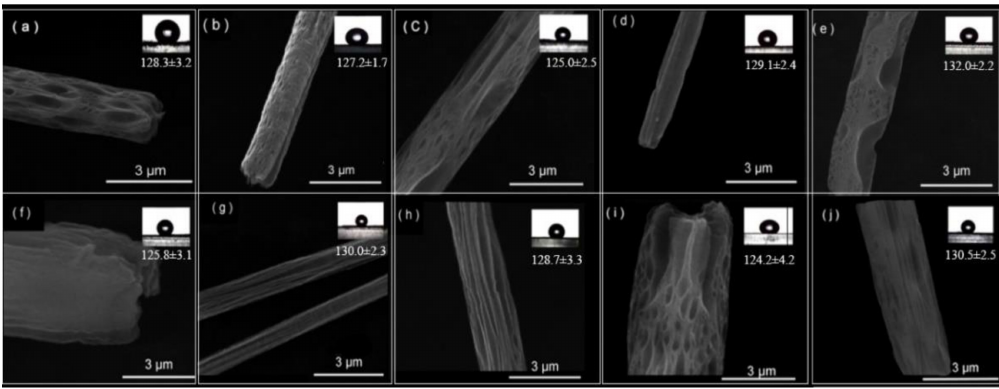
Figure 7. SEM micrographs of the surfaces ( a – j ) and the WCAs of the as-spun PS fibers fabricated from solutions with varying compositions.